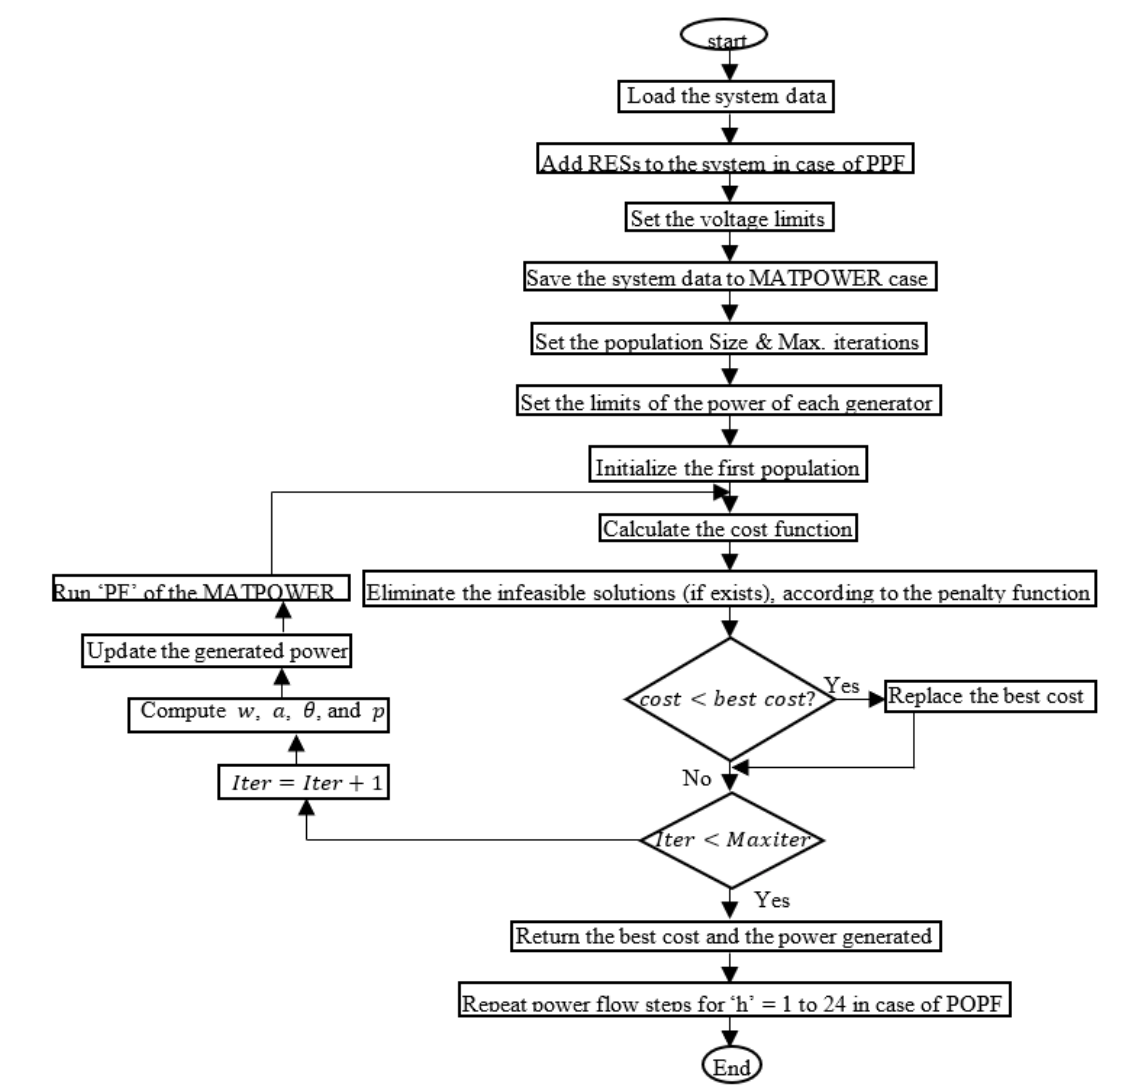
Figure 3. The steps of problem-solving using the CSA.